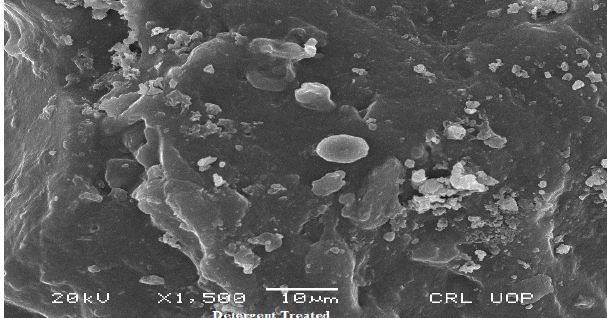
Figure 16. Detergent-treated CR .